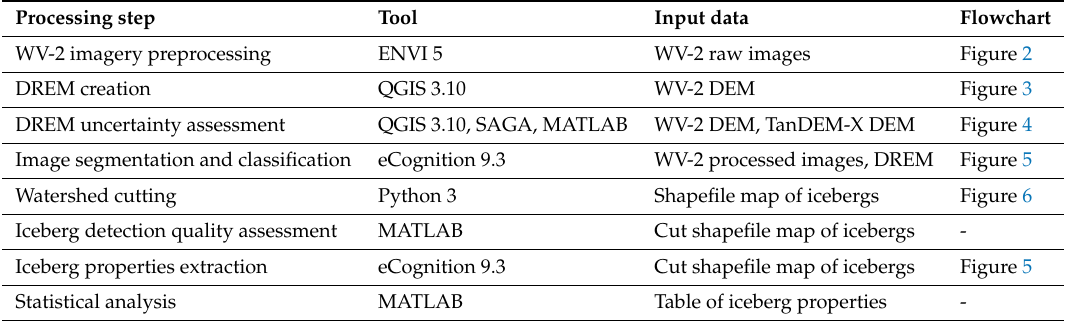
Table A1. Summary of processing steps, tools used for their execution and input data at each